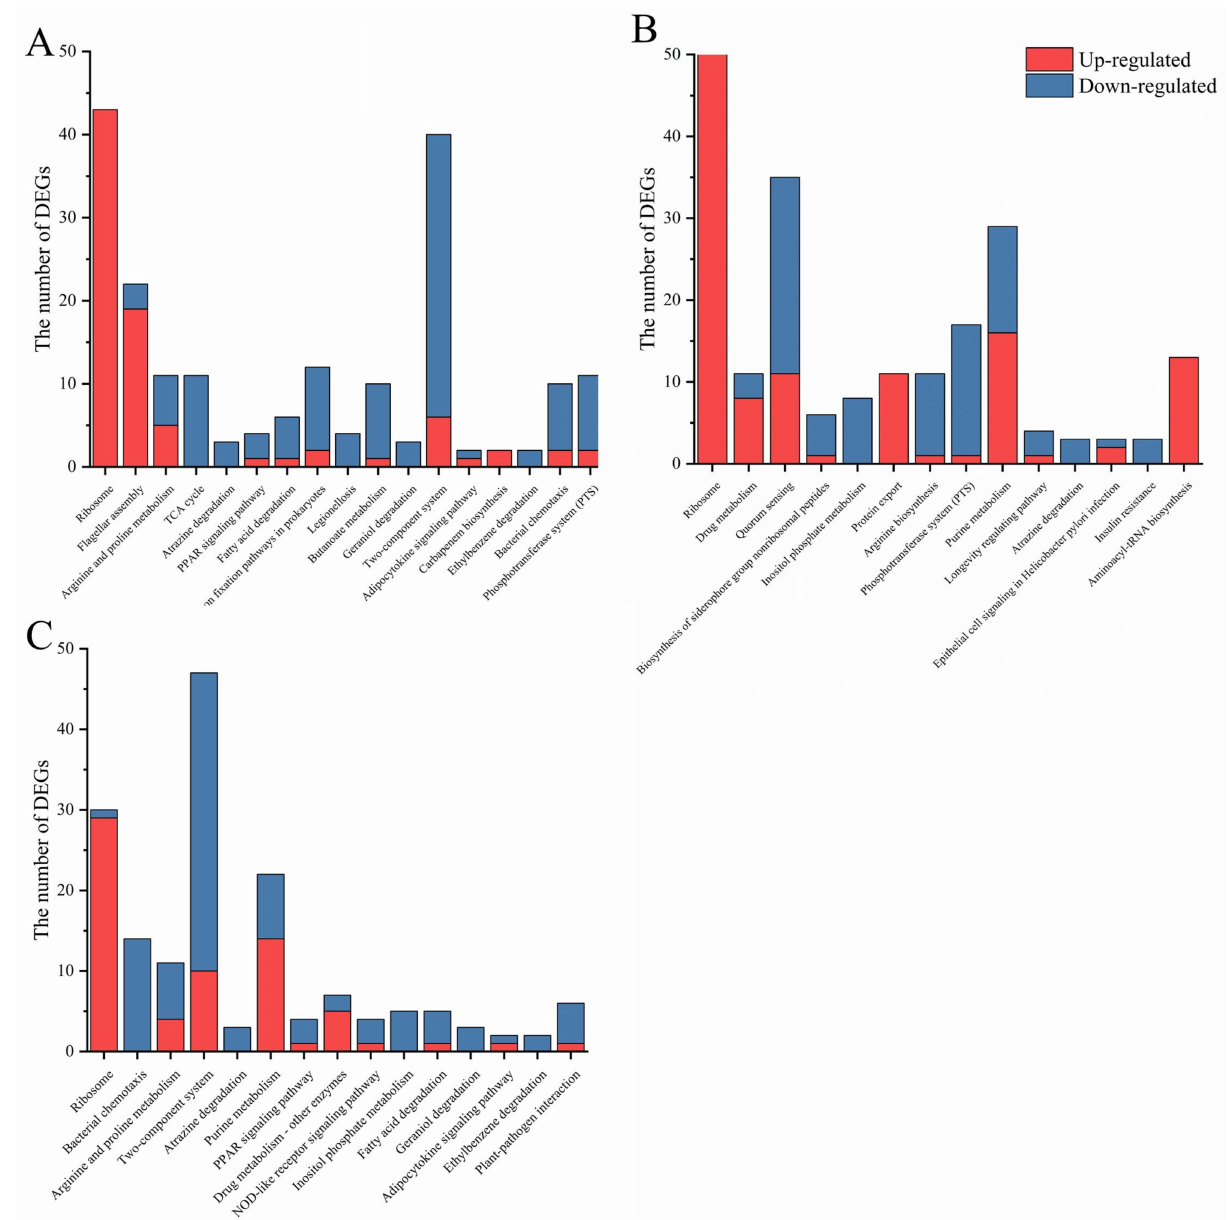
Figure 2. Functional enrichment analysis of DEGs based on the KEGG database. ( A ) ∆ dksA ; ( B ) ∆ relA ∆ spoT ; and ( C ) ∆ dksA ∆ relA ∆ spoT